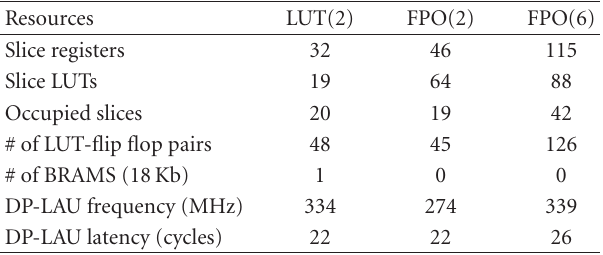
Table 4: Resource usage by the LUT-based approach (latency of two cycles) and Xilinx FPO (latency of two and six cycles) for transformation of exponent to SP